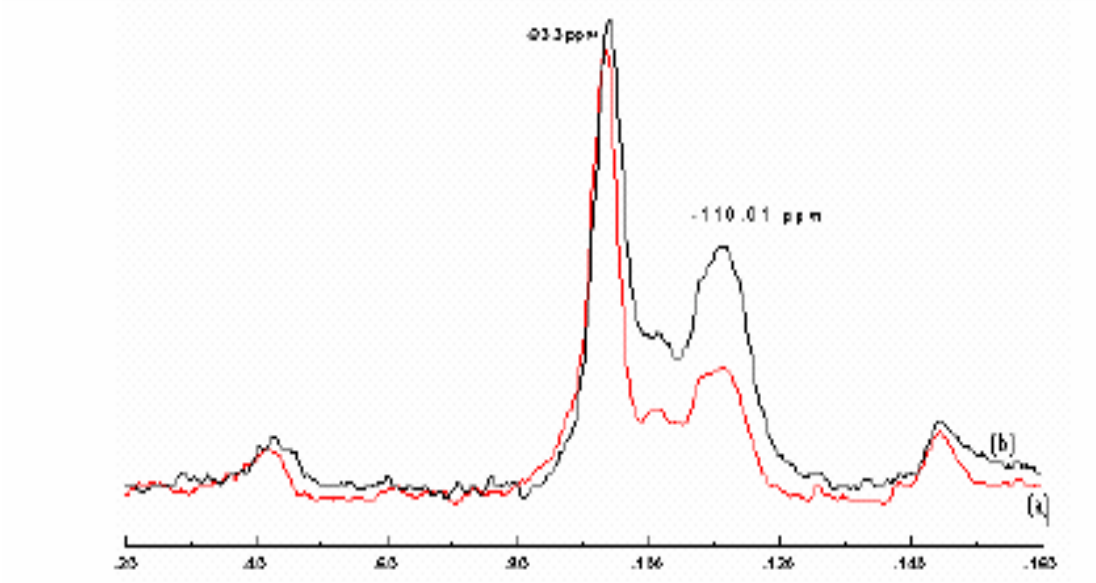
Figure 4. 29 Si MAS NMR spectra of (a) “Raw-Maghnite” and (b) “H-Maghnite 0.25M”